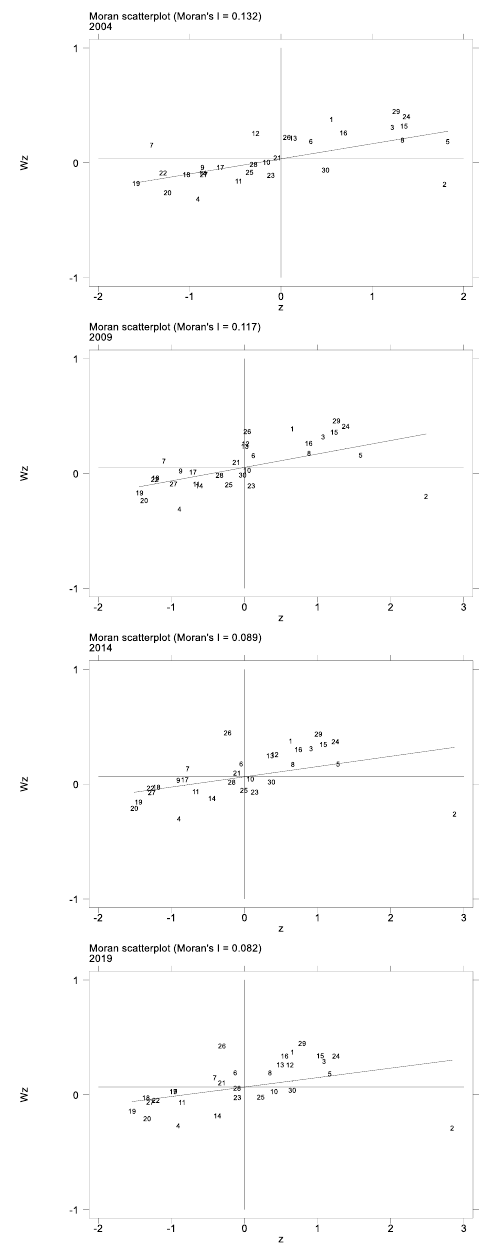
Figure 3. Moran scatter plot of energy efficiency for 2004, 2009, 2014 and 2019. Note: Anhui, Beijing, Fujian, Gansu, Guangdong, Guangxi, Guizhou, Hainan, Hebei, Henan, Heilongjiang, Hubei, Hunan, Jilin, Jiangsu, Jiangxi, Liaoning, Inner Mongolia, Ningxia, Qinghai, Shandong, Shanxi, Shaanxi, Shanghai, Sichuan, Tianjin, Xinjiang, Yunnan, Zhejiang, and Chongqing are replaced by the numbers 1–30,